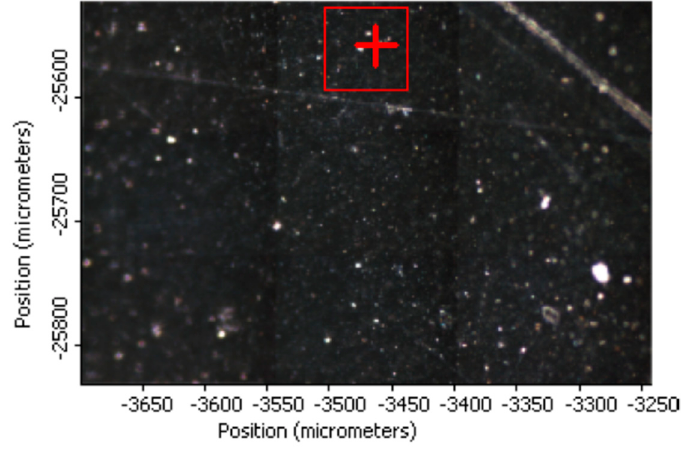
Membranes 2022 , 12 , x FOR PEER REVIEW Figure 7. Optical image of PVA_GO_CNT_COOH sample with a representative area of 450 um × 300 um.